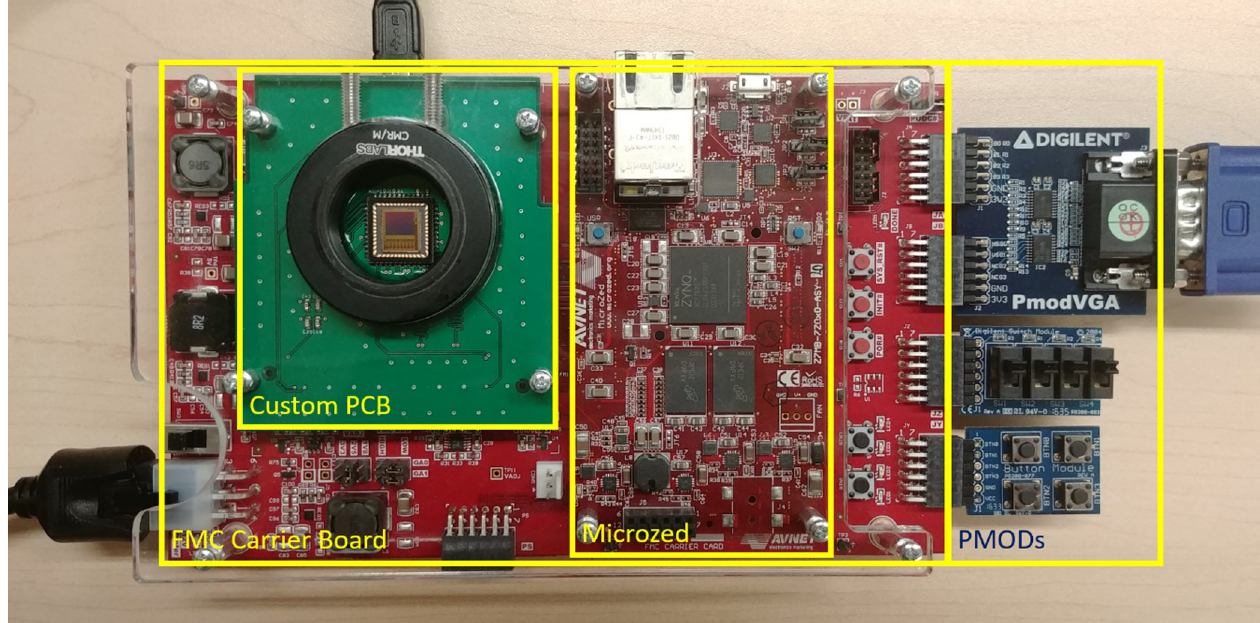
Fig 1. Full camera prototype containing the Microzed, FMC carrier board, custom camera sensor module and PMOD extensions. An acrylic protective cover and c-mount lens provide a temporary solution for safe mounting.